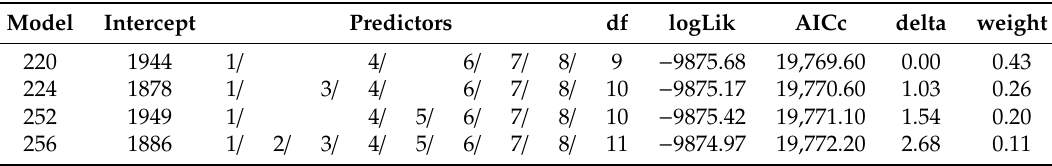
Table 1. Models with delta AICc below